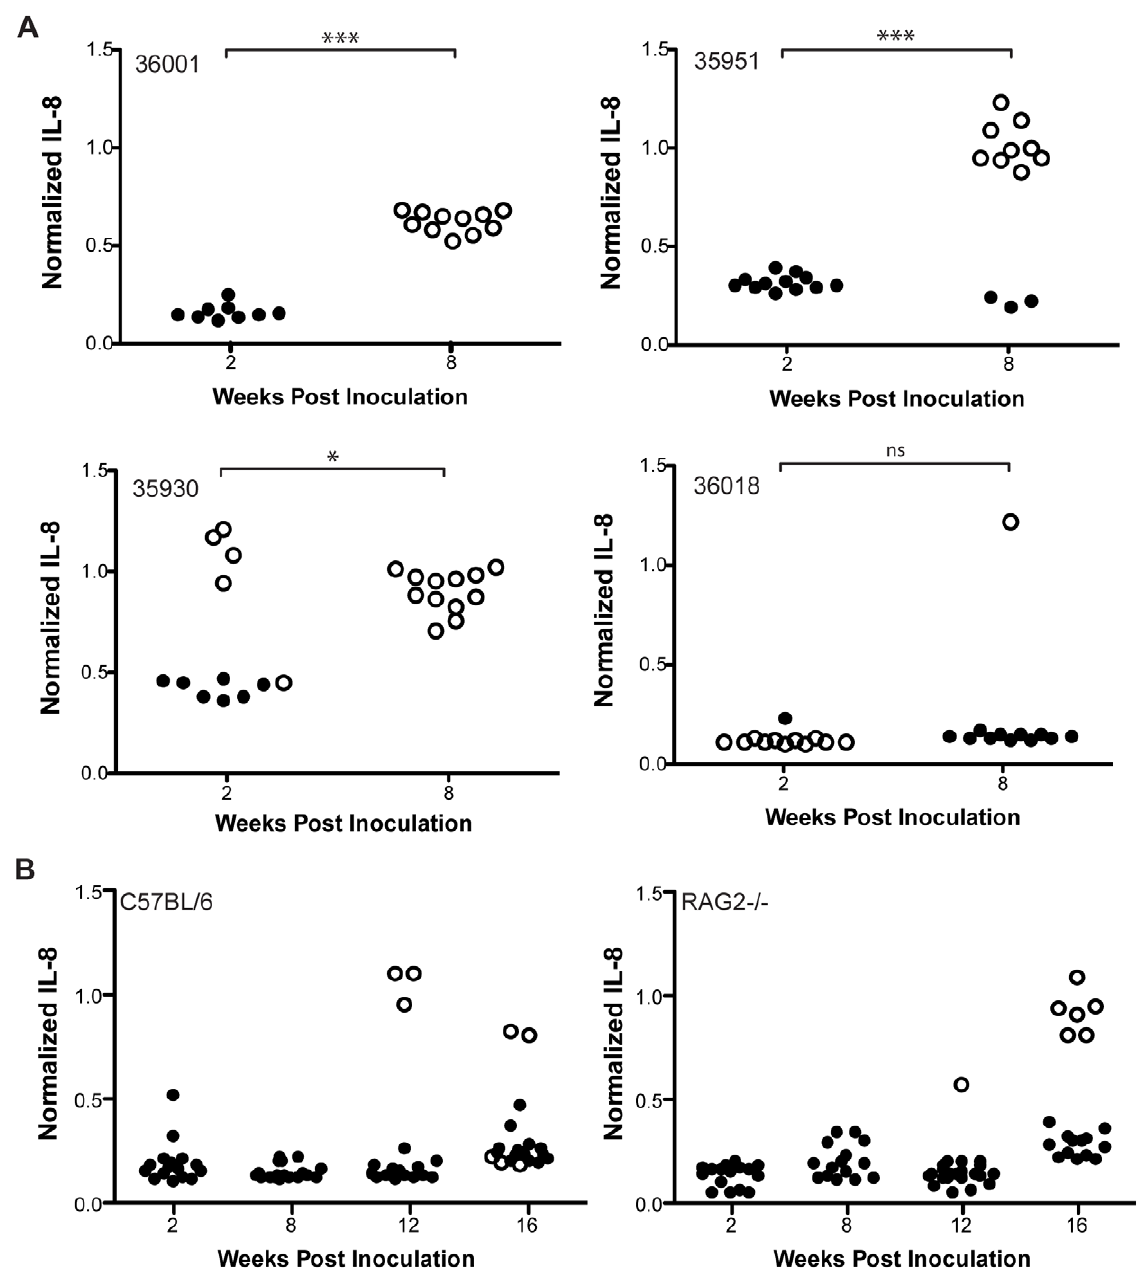
Figure 10. Recombination of cagY during infection of rhesus macaques and mice can also restore the capacity to induce IL-8. Rhesus macaques and mice were inoculated with mOut2, which does not induce IL-8 or translocate CagA. Single colony isolates were recovered and tested for induction of IL-8 and compared to mOut2 by cagY PCR-RFLP. (A) Colonies from three monkeys (36001, 35951, 35930) showed significantly increased capacity to induce IL-8 at 8 weeks compared to 2 weeks PI, which was associated with changes in cagY RFLP. The fourth monkey (36018) was colonized with a mixture of cagY genotypes that induced low IL-8 similar to mOut2. (B) Colonies recovered from WT and RAG2 2 / 2 mice typically induced low IL-8 similar to input mOut2, with no change in cagY . * P , 0.05; *** P ,